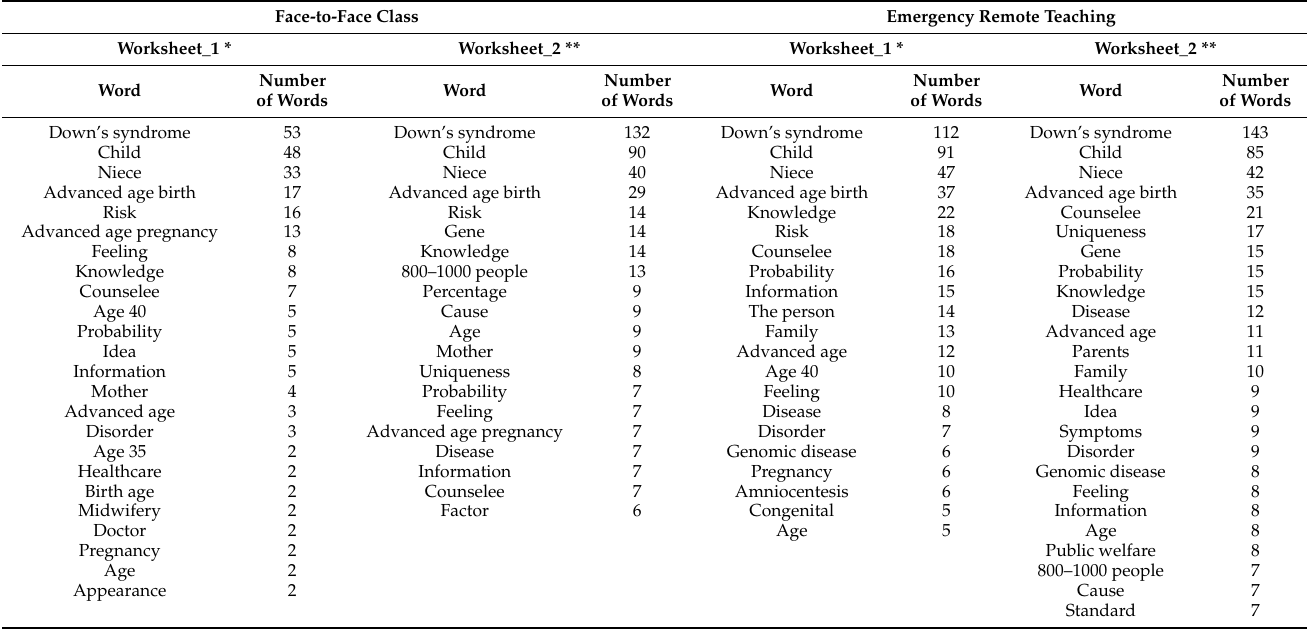
Table 2. Comparison of words (English equivalents) and their total incidence in class worksheets by type of class. Face-to-Face Class